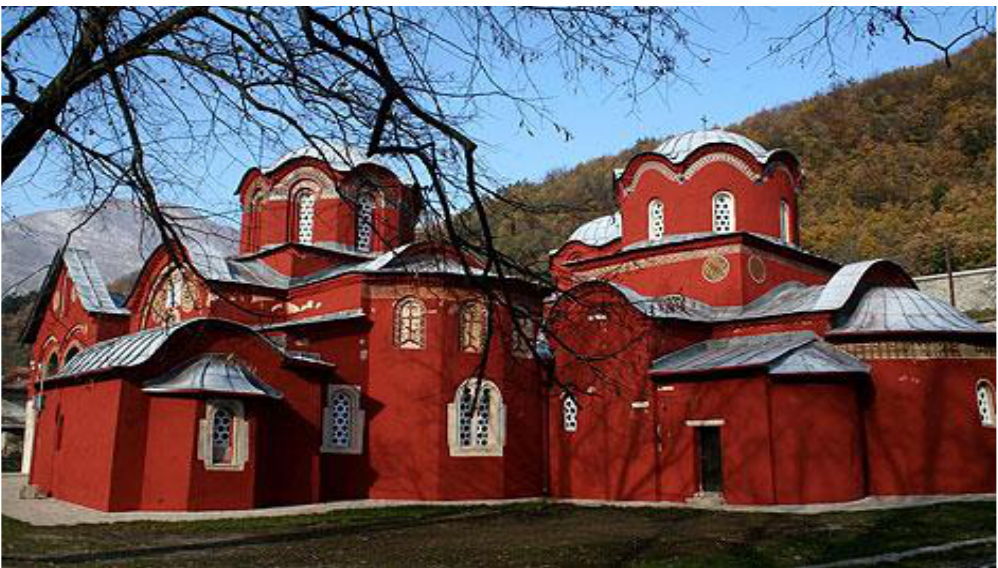
Fig. 1. Patriarchate of Peja (Municipality of Peja,